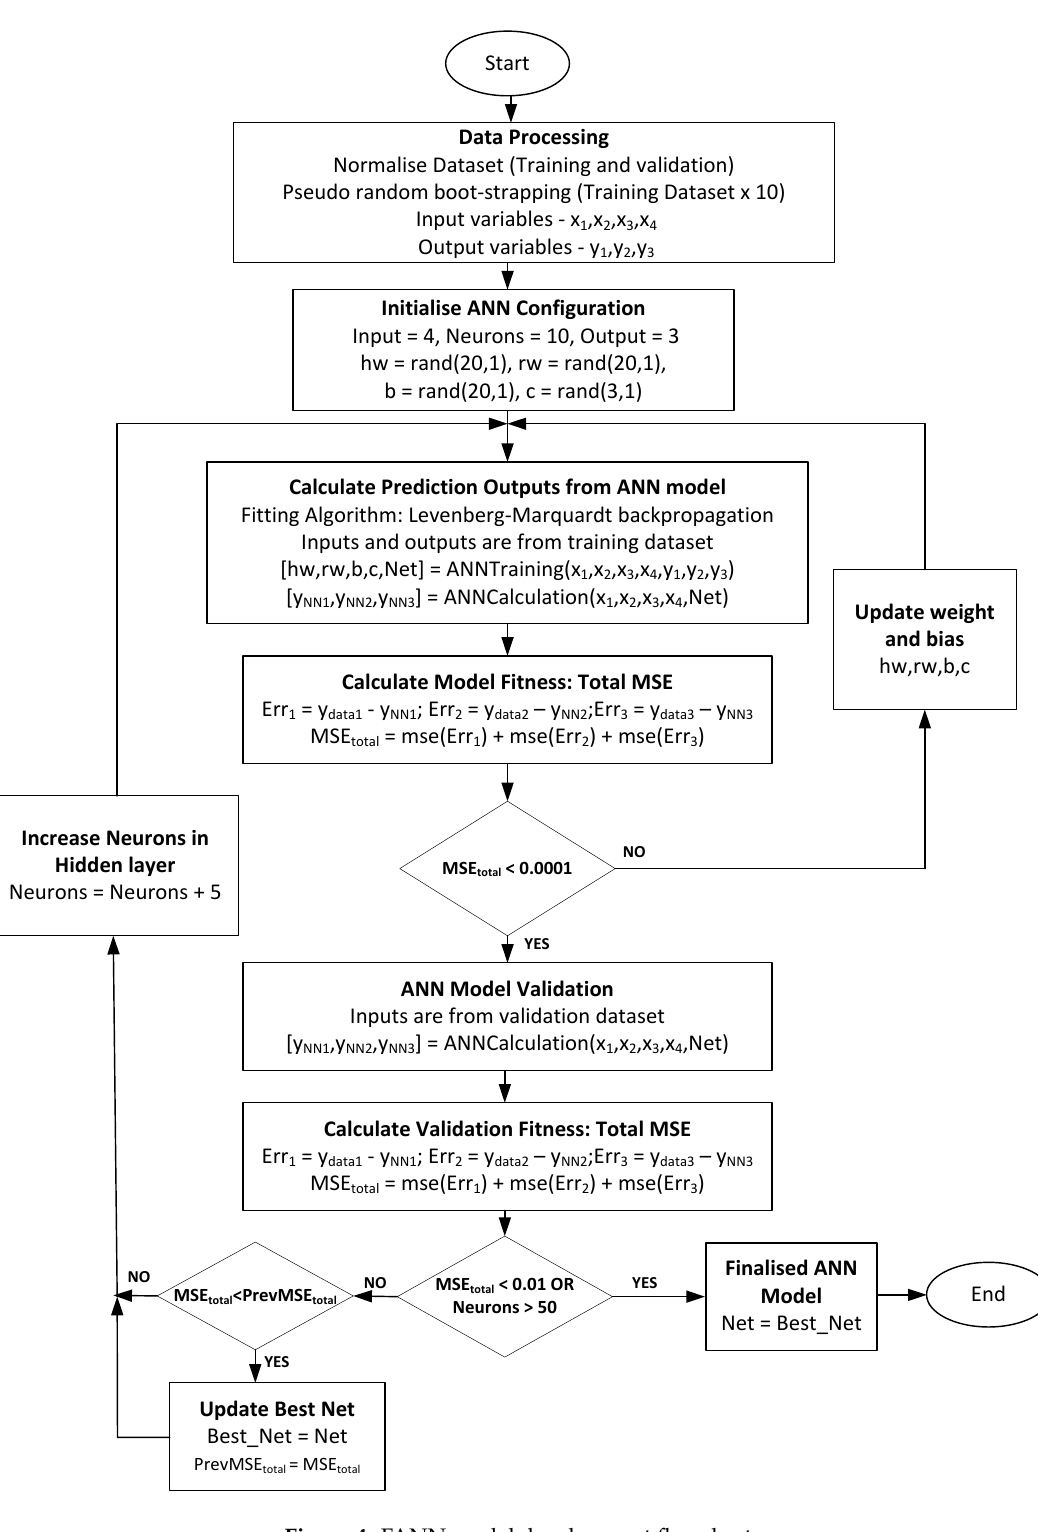
Figure 4. FANN model development flowchart.